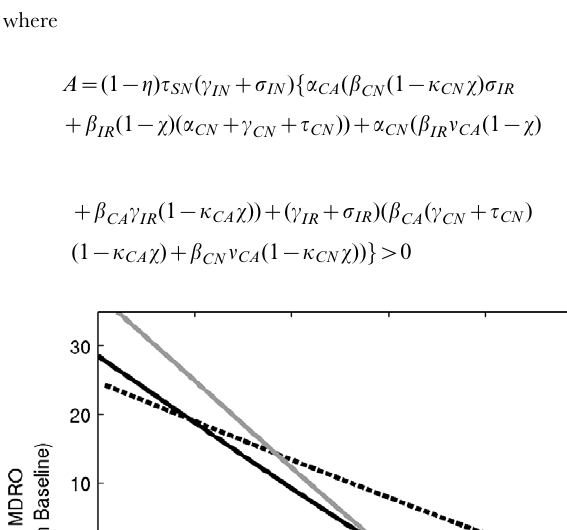
Figure 2. The percent of patients colonized (A) and infected (B) with an MDRO at one year when the compliance or efficacy of four interventions are varied. Solid black line ( x ) - contact precautions, dotted line ( k CN ) - screening of colonized patients not on antimicrobials, dashed line ( k CA ) - screening of colonized patients receiving antimicrobials, and grey line ( g ) - compliance with hand hygiene measures. The dots mark the baseline values.